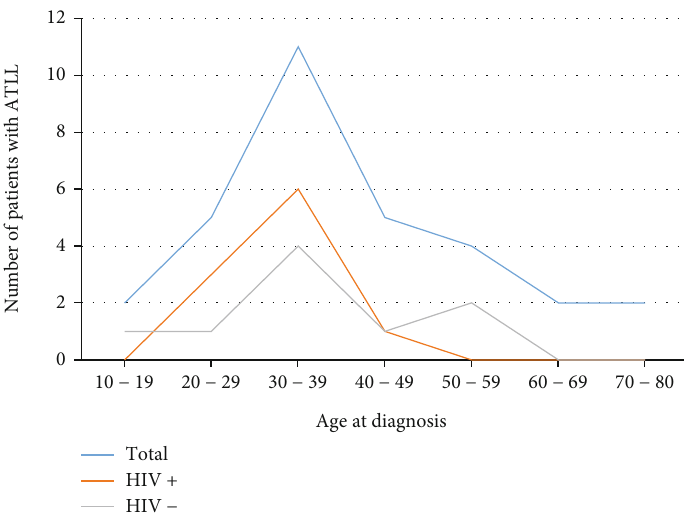
Figure 2: Distribution of age at diagnosis of ATLL for the total number of patients, as well as those that are known to be HIV positive or HIV negative. ATLL: adult T-cell leukaemia/lymphoma; HIV: human immunode fi ciency